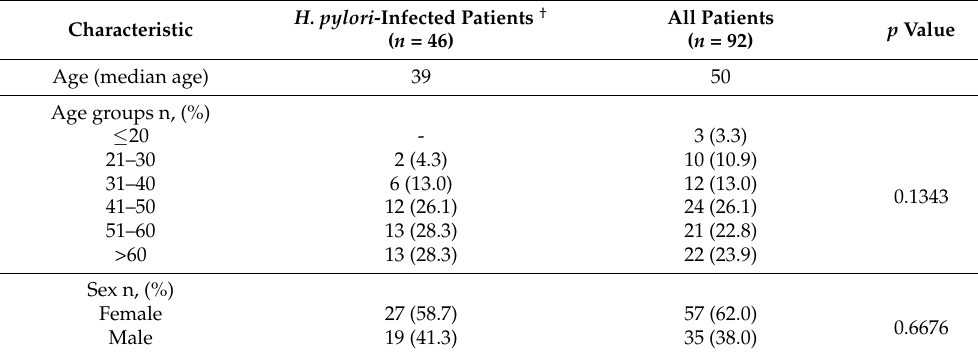
Table 1. Baseline characteristics of the participants.